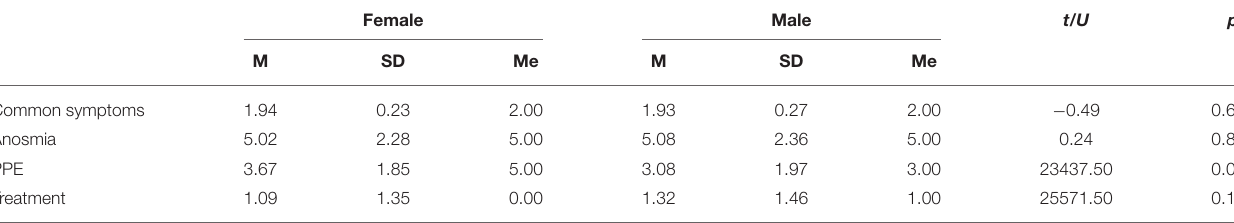
TABLE 3 | Gender comparison using t -test/Mann-Whitney U -test.